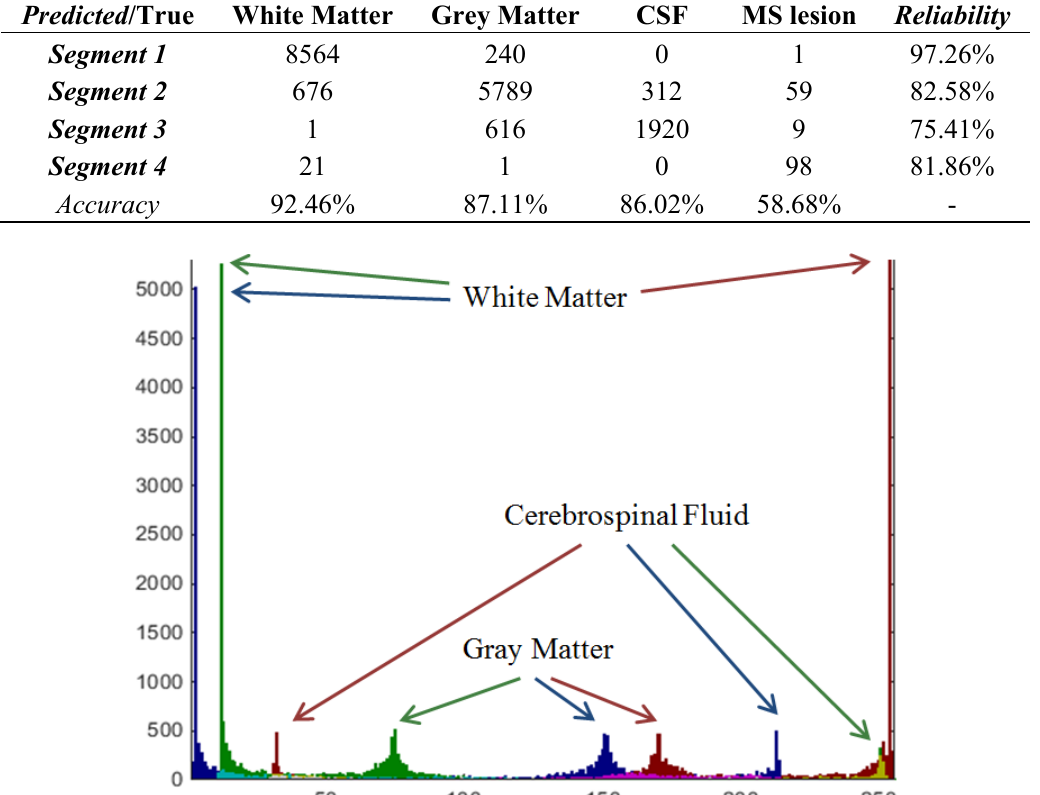
Figure 6. RGB histogram for slice 95 of moderate MS lesion data after the 12-bit to 8-bit pre-processing. The positions of the peaks for the main tissue types are indicated, and are consistent across the different slices due to